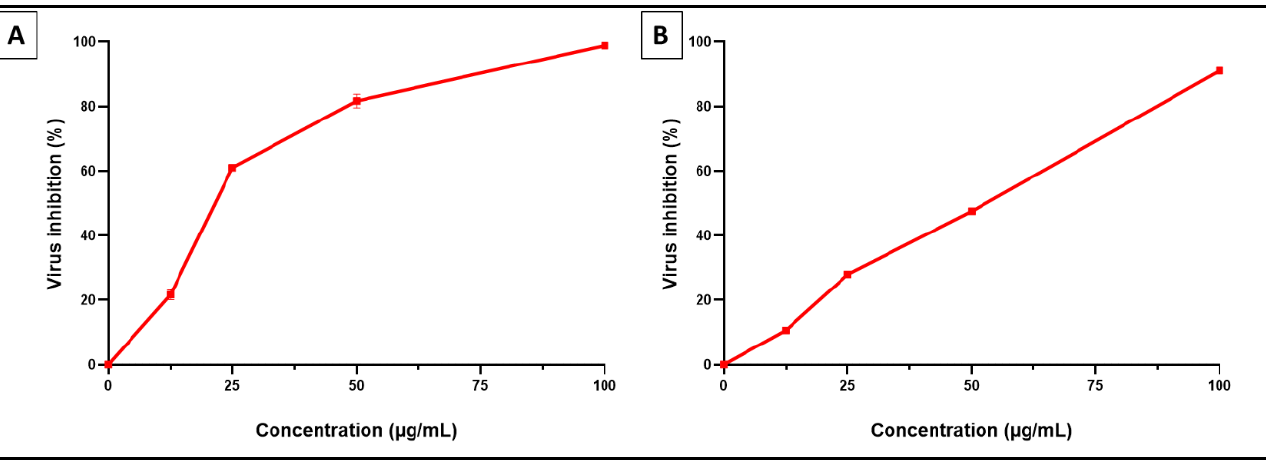
Figure 2. Cytotoxicity curve of SCRE (with CC 50 of 70.36 ± 0.8 µg/mL). The results are exhibited as mean ± SD.